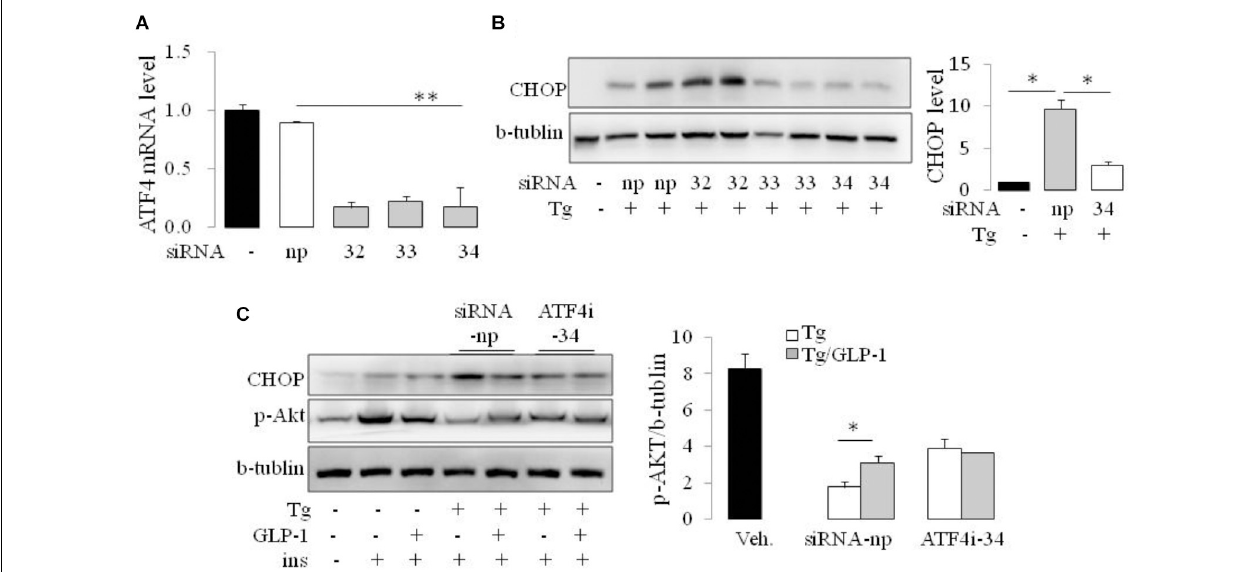
FIGURE 3 | GLP-1 affected insulin signaling in ER-stressed adipocytes via ATF4. The adipocytes were transfected with non-specific (siRNA-np) or ATF4 specific siRNA fragments (ATF4i-32, 33, 34) to inhibit transcription of ATF4. Total cell extracts were then analyzed by quantitative PCR for ATF4 (A) and immunoblotting for CHOP (B) . Data represent means ± SE of images from the plot B and plot C. ∗ P < 0.05. (C) 24 h after transfection with siRNA-np or ATF4i, cells were fasted for 6 h in low-glucose DMEM media with 0.2% BSA (fasting media) and then were treated with vehicle alone or thapsigargin (Tg) in the absence or presence of 50 nM GLP-1 in fasting media for 16 h. The cells were then stimulated with insulin (100 nM) in fasting media for 10 min. Three wells of cell extracts were pooled together and were analyzed by immunoblotting for phospho-AKT Ser47 (p-AKT), CHOP, and b-tublin (loading control). Data represent means ± SE of three independent experiments. ∗ P < 0.05 and ∗∗ P <